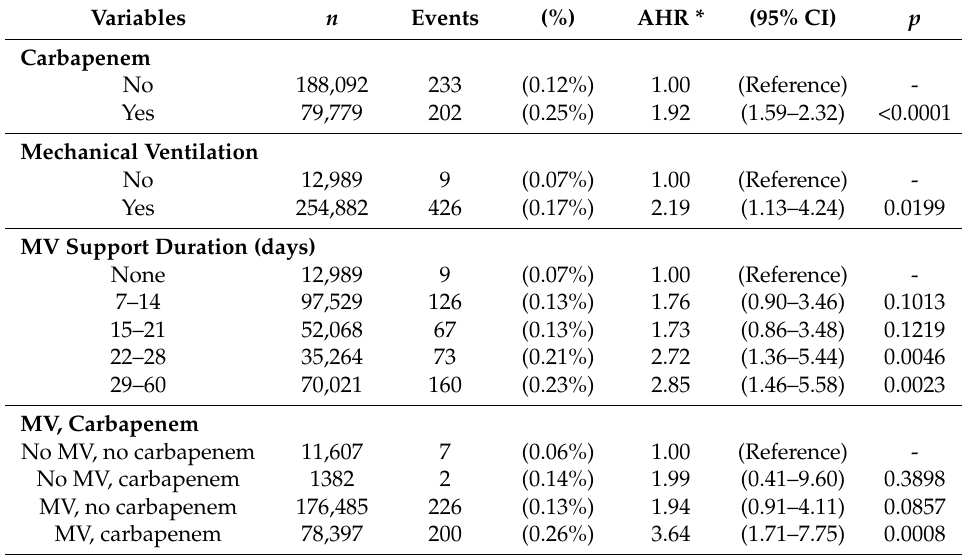
Table 3. Subgroup analysis of the interaction between carbapenem therapy and mechanical ventilation support for C. difficile infection in critically ill ICU patients.